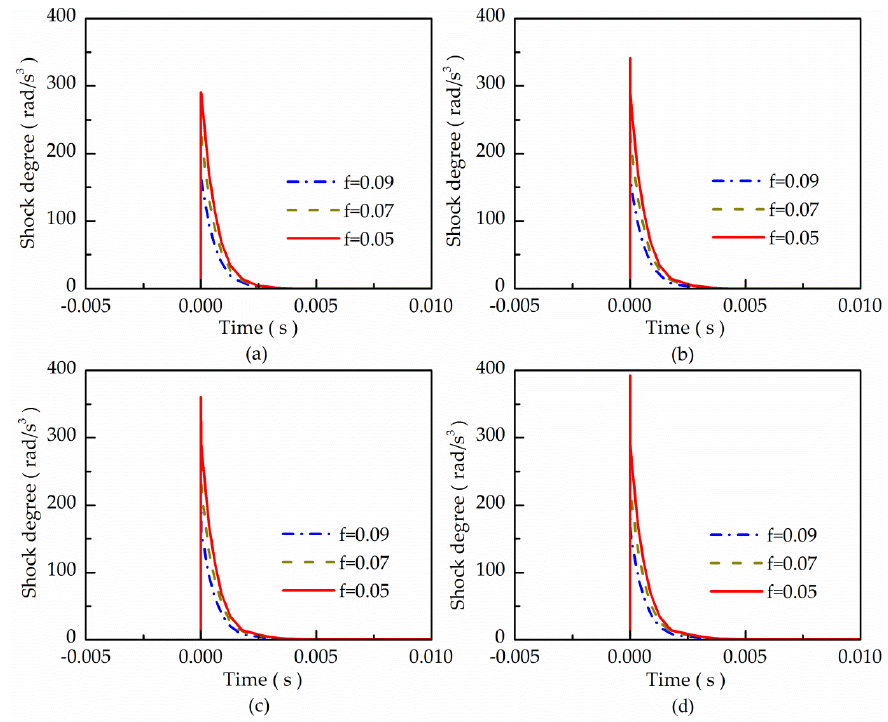
Figure 4. Shock degree contrast curve of synchronization early stage: ( a ) shift speed di ff erence 600 r / min; ( b ) shift speed di ff erence 700 r / min; ( c ) shift speed di ff erence 800 r / min; ( d ) shift speed di ff erence 900 r /